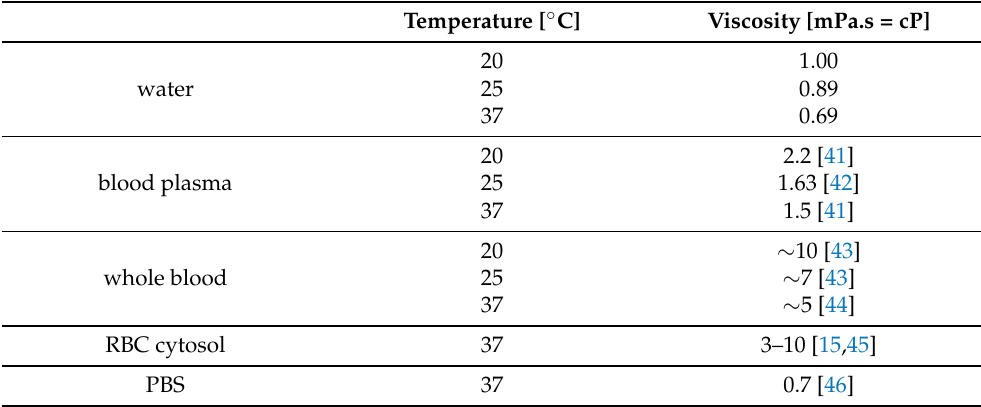
Table 1. Viscosity measurements. Blood is a shear thinning fluid and thus the whole blood viscosity depends on shear rate. The values listed here approximately correspond to the shear rates 70–100 s − 1 . Temperature [ ◦ C] Viscosity [mPa.s =